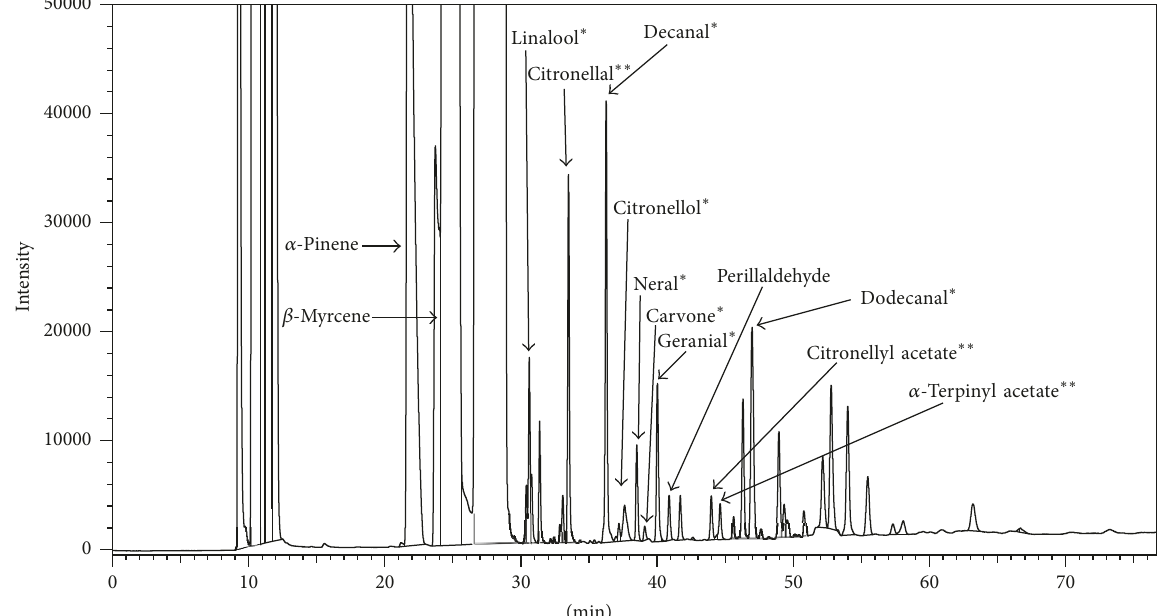
Figure 4: Chromatogram from Hamlin Late Symptomatic. Note . While 2-decenal and 2,4-decadienal were quantifiable in this sample, they were not labeled on the chromatogram as the peaks are too small to be seen. ∗ Compound has lower concentration compared to HLA. ∗∗ Compound has higher concentration compared to HLA.